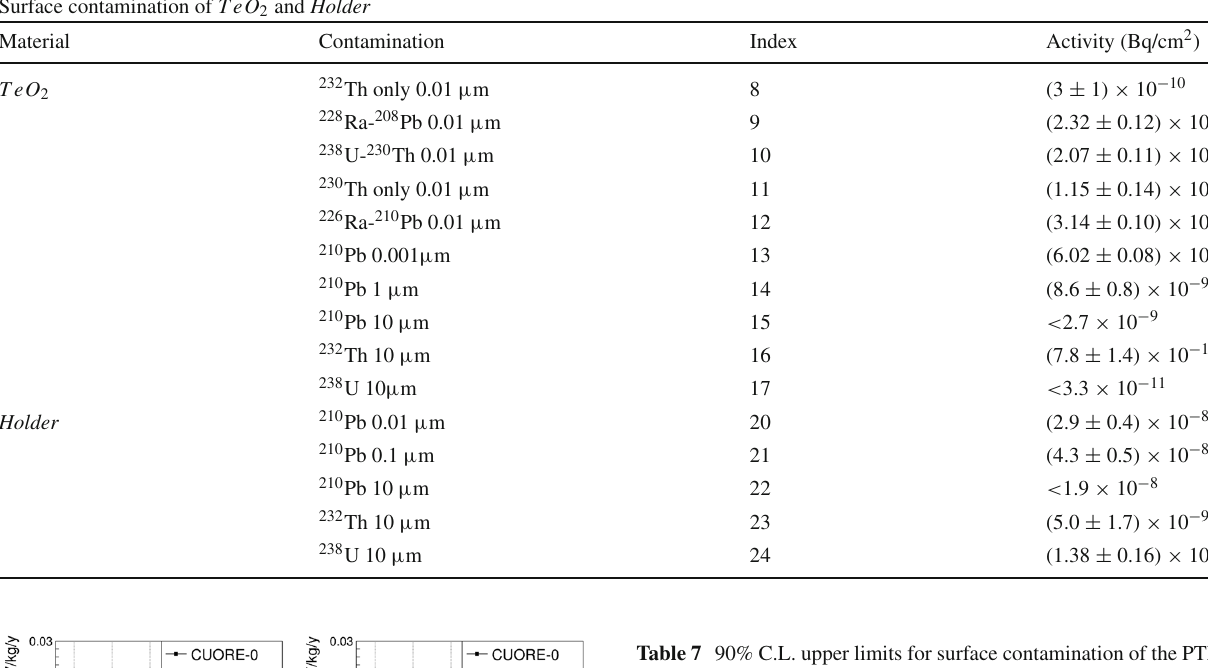
Table 7 90% C.L. upper limits for surface contamination of the PTFE supports based on the background model of CUORE-0 [42] with